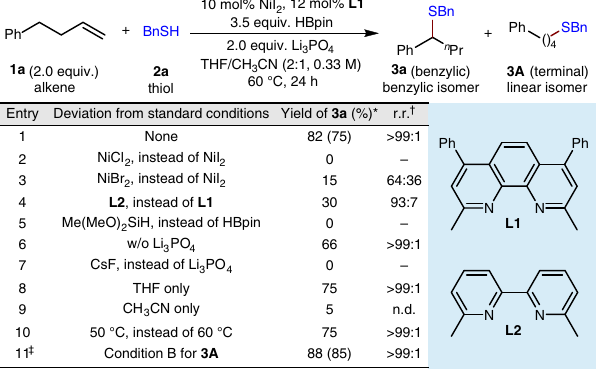
Fig. 2 Optimization of regiodivergent remote hydrothiolation. *Yields were determined by gas chromatography (GC) analysis using n -tetradecane as the internal standard. The yield within parentheses is the isolated yield and is an average of two runs (0.20 mmol scale). † r.r. refers to regioisomeric ratio, representing the ratio of the major product to the sum of all other isomers as determined by GC analysis. ‡ The linear thioether ( 3A ) is obtained as a single isomer; conditions B for terminal selectivity: NiI 2 (5mol%), L2 (6mol%), (MeO) 2 MeSiH (3.5 equiv.), DMSO (0.50 M), 50°C, 48h. Ph, phenyl; Bn, benzyl; n Pr, n -propyl; HBpin, pinacolborane; THF, tetrahydrofuran;